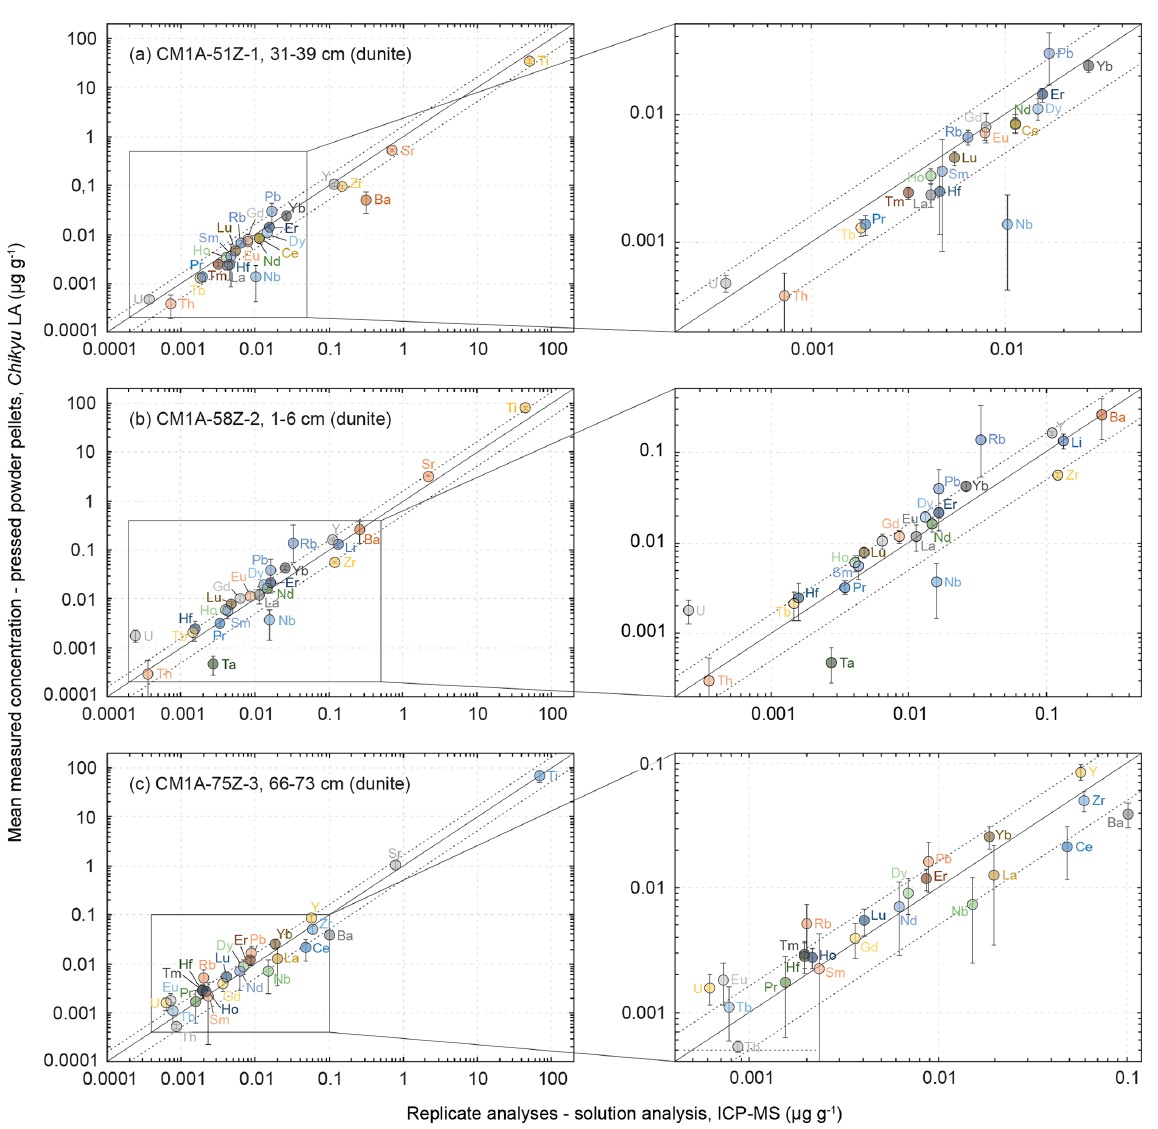
Figure 9. Comparison of the mean measured concentrations obtained by LA-ICP-MS on pressed powder pellets with the analysed replicates for the same samples (solution analysis, IES-AS (Taiwan) for samples in (a) and (c) and GET (France) for the sample in (b) ) for three dunite samples from Hole CM1A. The selected samples are (a) CM1A-51Z-1, 31–39cm ( n = 6), (b) CM1A-58Z-2, 1–6cm ( n = 6), and (c) CM1A-75Z-3, 66–73cm ( n = 5). The black solid line is the 1:1 line between the concentrations determined by LA-ICP-MS on-board the D/V Chikyu and for the replicates. The black dashed lines represent 50% deviation from the 1:1